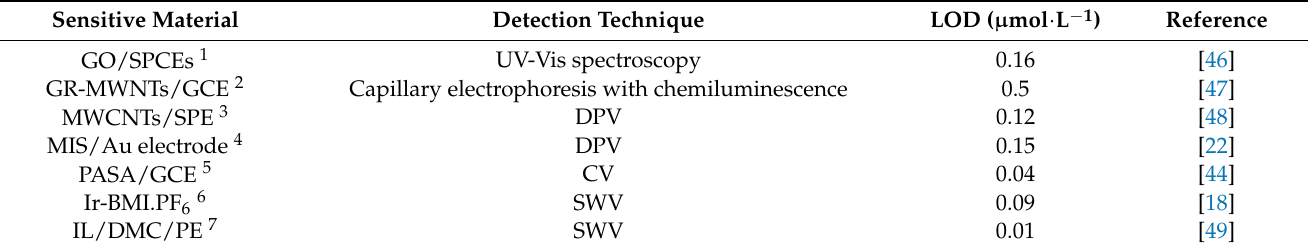
Table 6. Sensitive materials, detection techniques, and detection limits (LODs) of the main voltammetric sensors used for the detection of